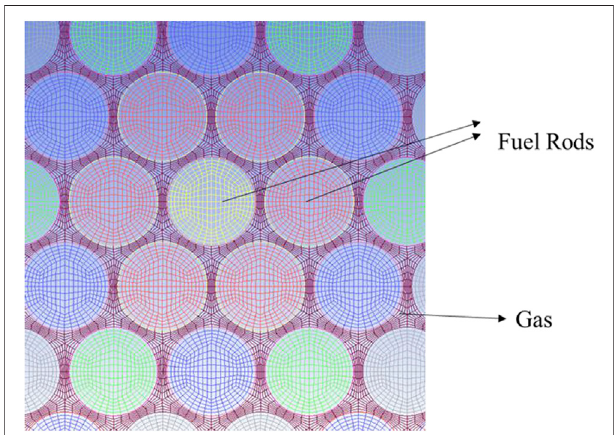
FIGURE 7 | Schematic diagram of CFD mesh.